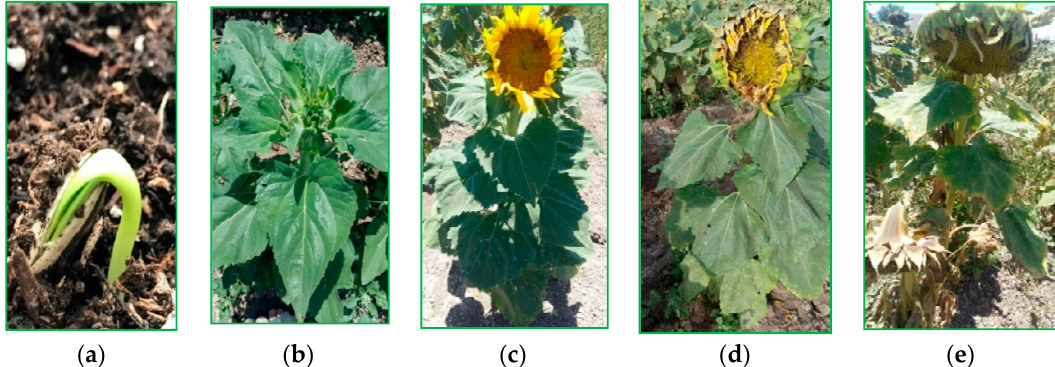
Figure 6. Development stages of plant growth for the full irrigation (treatment A) 100% ET C (Control). ( a ) Seedling emergence on 2 April. ( b ) Bud growth on 8 May when plant height ranged from 40 to 50 cm. ( c ) Initiation of flowering on 7 June, when plant height ranged from 100 to 130 cm. ( d ) Post-flowering on 20 June. ( e ) Approaching physiological maturity on 26 June, prior to harvest.